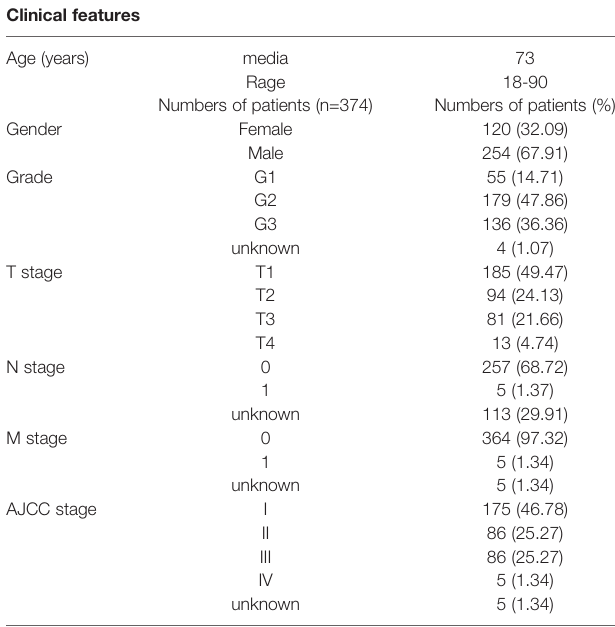
TABLE 1 | The clinical features of TCGA hepatocellular carcinoma